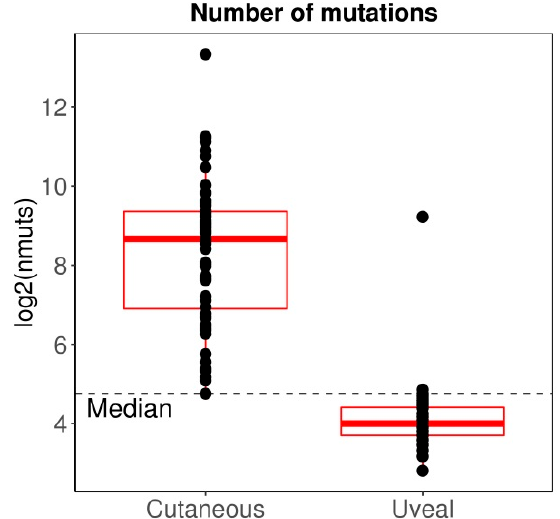
Figure 3. The mutation load of UM is in the lowest among all TCGAs, compared to cutaneous melanoma which has the highest. The median line has been calculated for all tumours included in the analysis. Data extracted from TCGA database through cBioPortal; 80 UM samples, 99 primary cutaneous melanoma samples. Expression data were normalized by TMM, log2 transformed, and scaled to allow proper comparison between datasets.